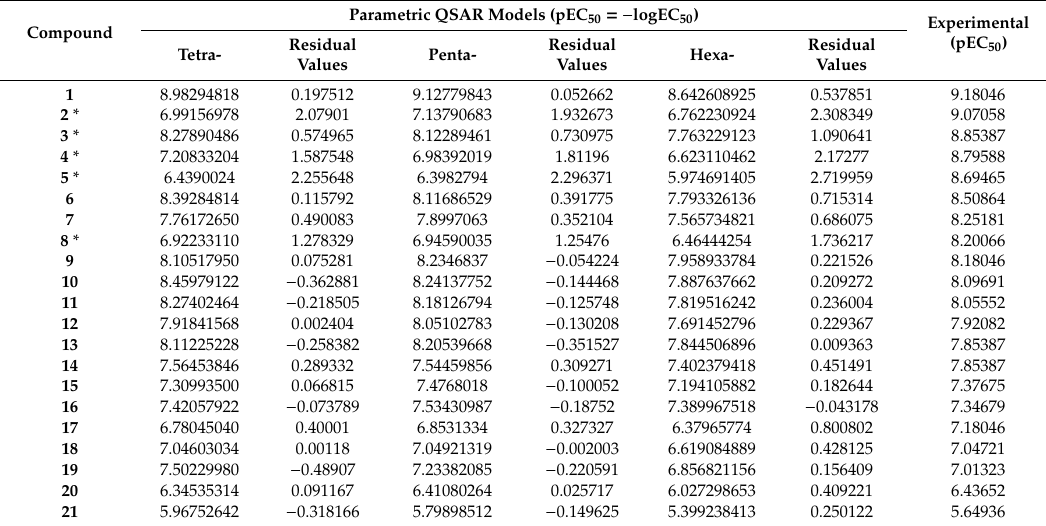
Table 3. Internal validation using the best built QSAR models (tetra-, penta- and hexaparametic).